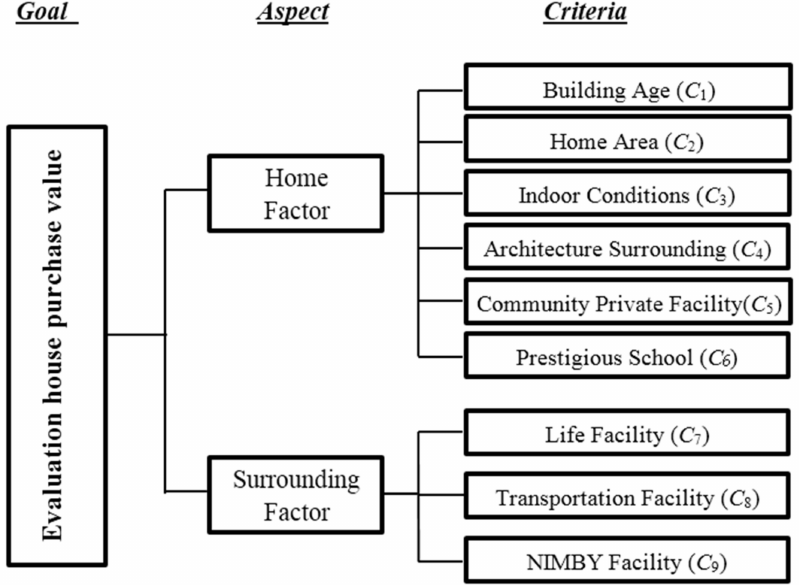
Figure 1. Hierarchical structure of the house purchase value